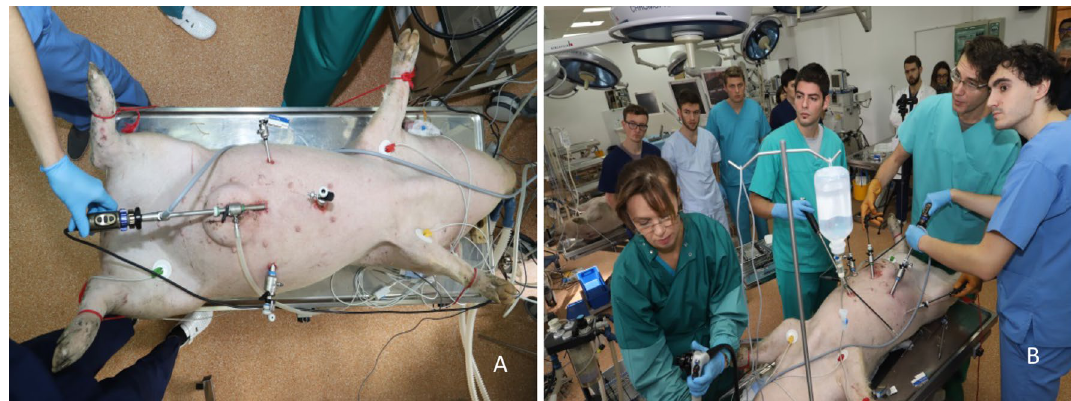
Figure 4. ( A ) Laparoscopic surgical access to the peritoneal cavity; ( B ) trans-oral insertion of the clip and deployment into the